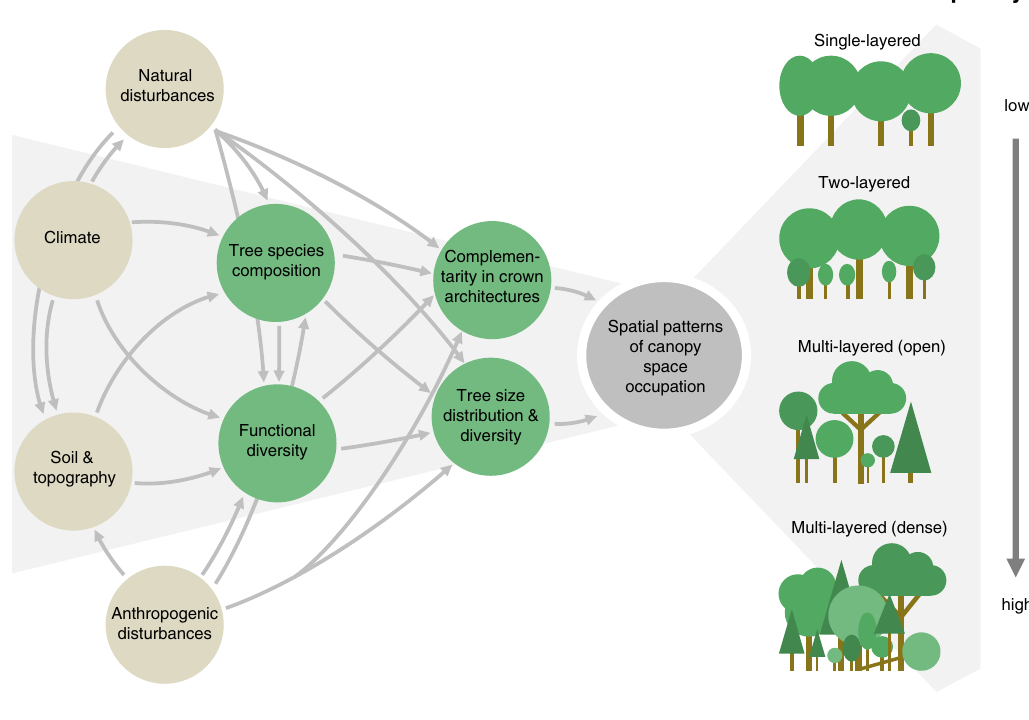
Fig. 1 Conceptual fi gure outlining the abiotic and biotic controls on forest structural complexity. Forest structural complexity increases with greater diversity of tree sizes and complementarity in crown